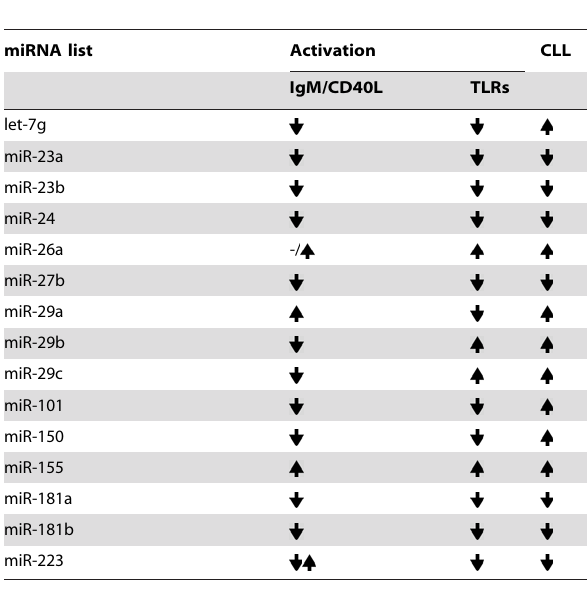
Table 1. Signature miRNA expression comparison between activated B cells and CLL cells relative to control B cells.